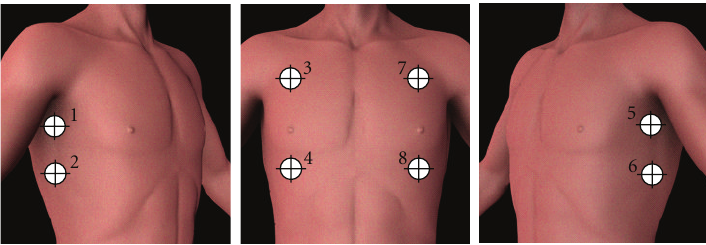
Figure 3: Pneumoscan data acquisition points.